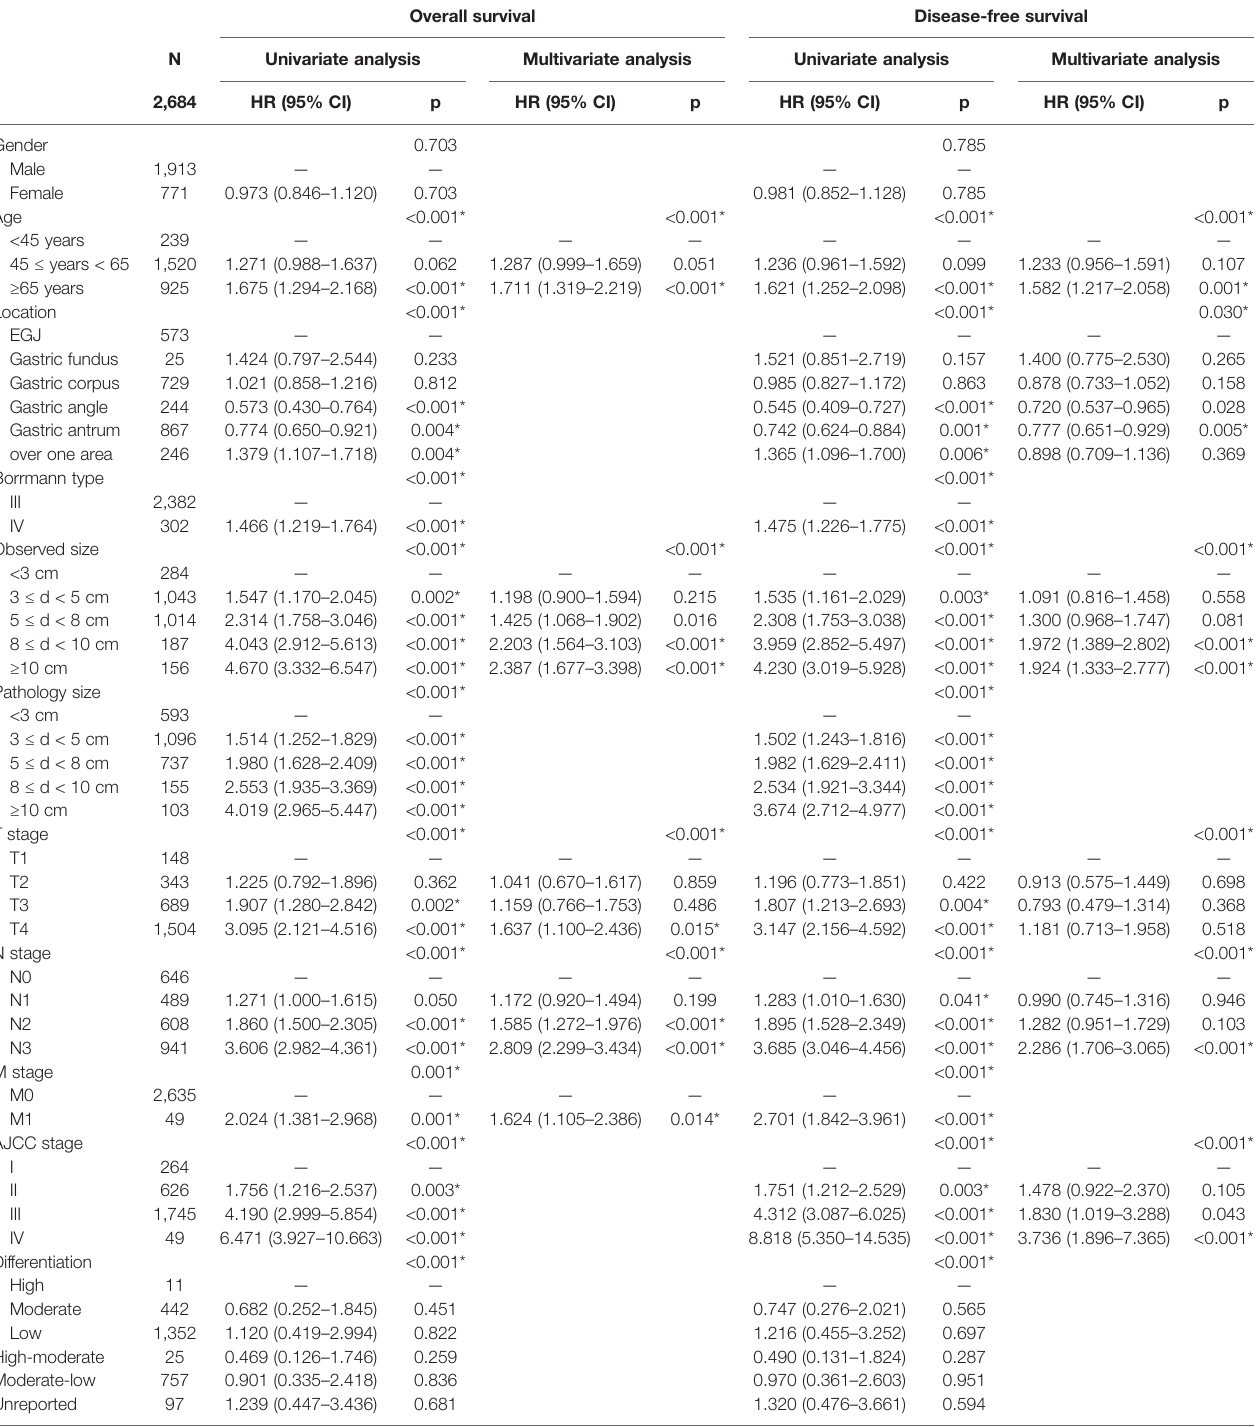
TABLE 1 | The general characteristics, univariate and multivariate analysis of overall survival and disease-free survival of 2,684 GC